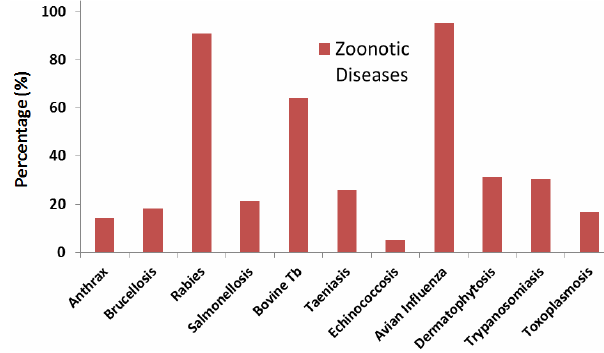
Fig. 1. Zoonotic diseases as perceived by the herdsmen